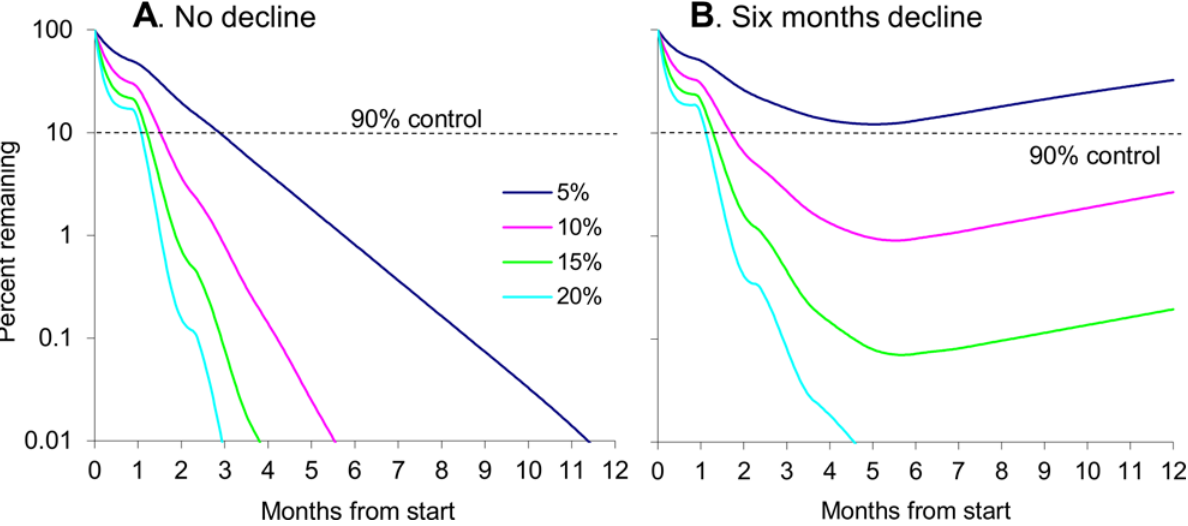
Fig 4. Time course of population change during various sorts of control in good isolated habitat. Percent of initial tsetse population remaining at various times after the deployment of targets at densities sufficient to get initial kill rates of 5 – 20% of tsetse per day in good isolated habitat, under conditions in which: (A) the efficacy of the targets did not decline, or (B) declined steadily to zero in six months. The population is regarded as the total of adult males and females, and can be taken as locally eliminated when the percent remaining dropped below 0.01%.